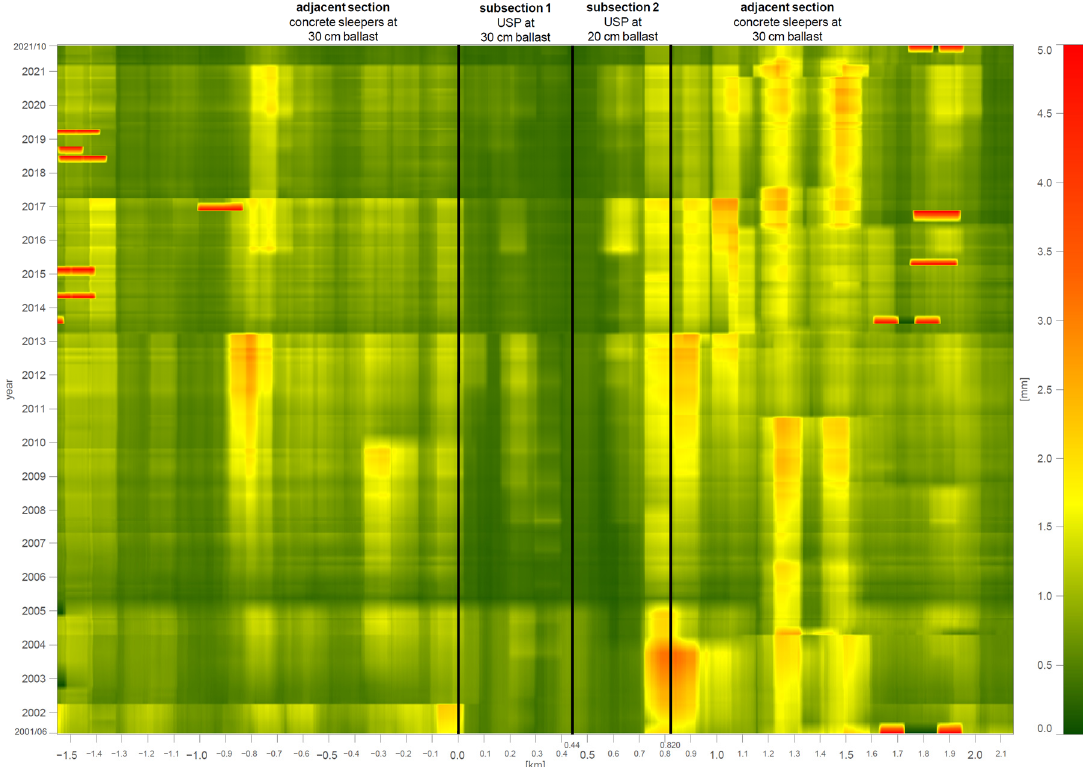
Figure 3. Waterfall diagram of SD i (100 m): arithmetic mean of the left and right rail’s standard deviation with an influence length of 100 m.